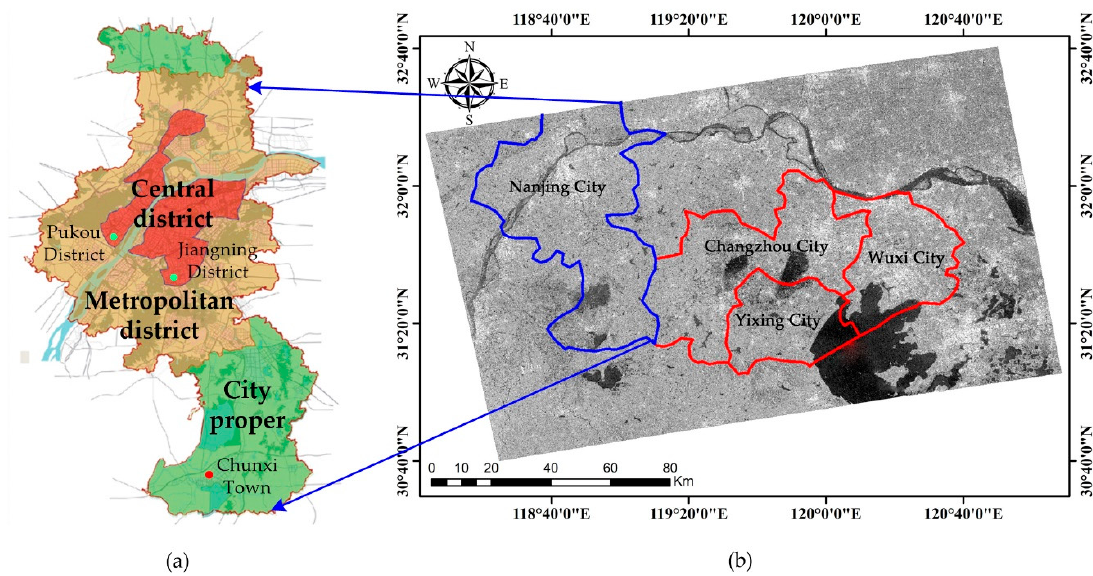
Figure 3. The study area: (a ) The administrative map of Nanjing City, Jiangsu Province, China. ( b ) The Sentinel-1 SAR image. The blue contour area was used as the test site and the red outline areas were used as the training samples.